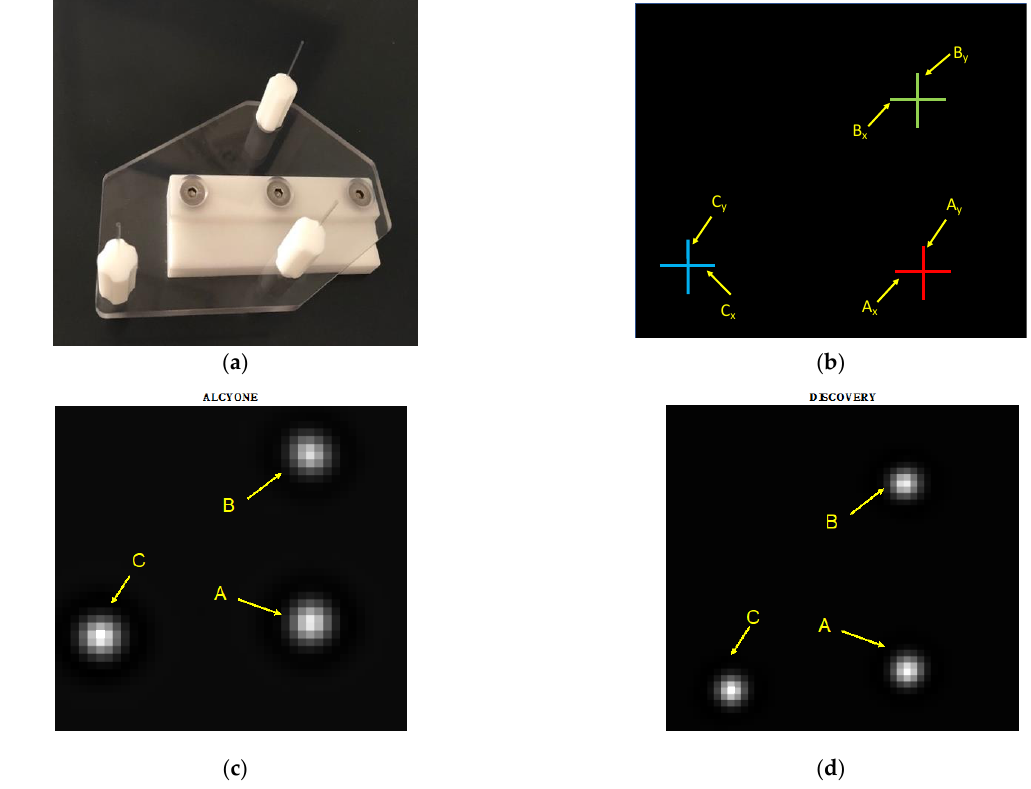
Figure 3. NEMA phantom, with examples of images acquired with Alcyone and Discovery. ( a ) the phantom; ( b ) schematic representation of the lines along which the FWHM of the PSF was considered for spatial resolution evaluation; ( c ) example image acquired from Alcyone; ( d ) example image acquired by Discovery.